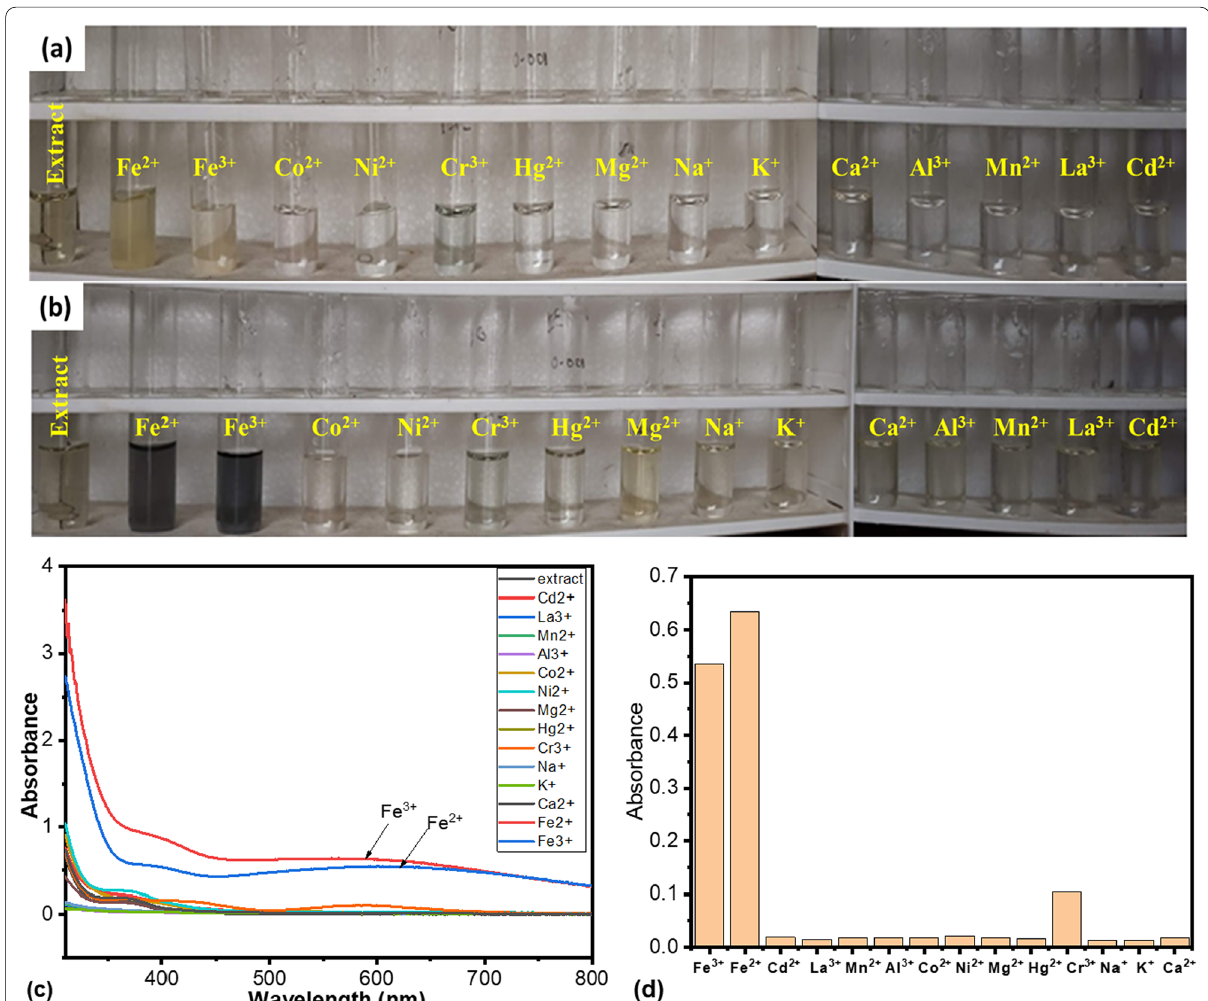
Fig. 2 a The color changes of different metal ions in the ( a ) absence and ( b ) presence of T. chebula extract. c UV–Vis spectra, d bar graph showing the absorbance of different metal ions in the presence of T. chebula